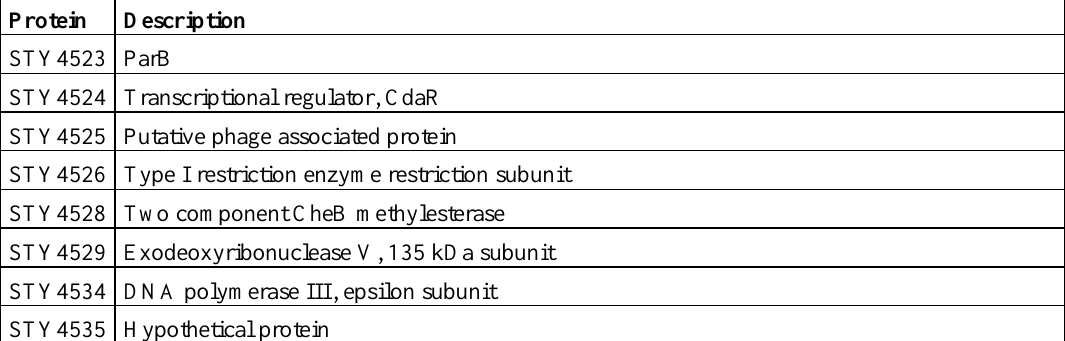
Table 2: List of proteins in SPI-7. 80 out of 148 proteins were analyzed using bioinformatics tools in order to assign predicted functions to these proteins which are largely unconnected to one